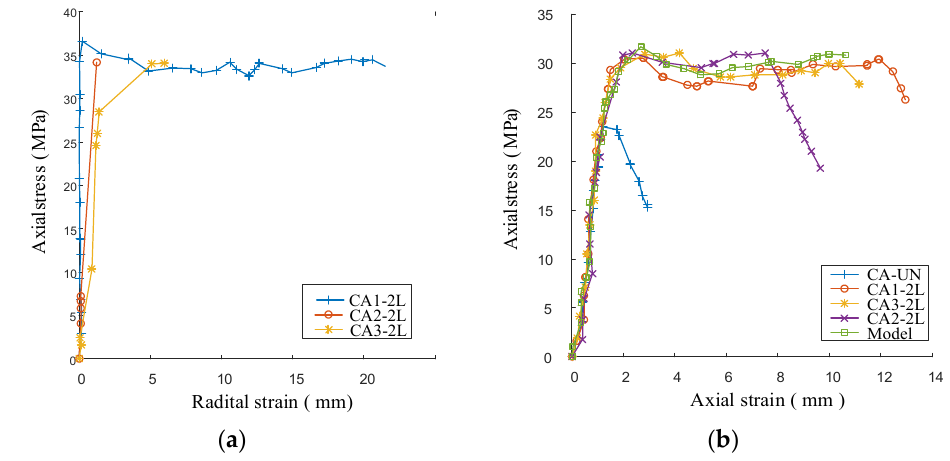
Figure 10. Stress vs. ( a ) radial and ( b ) axial strain for cylindrical specimens with two layers of textile reinforcement [74].